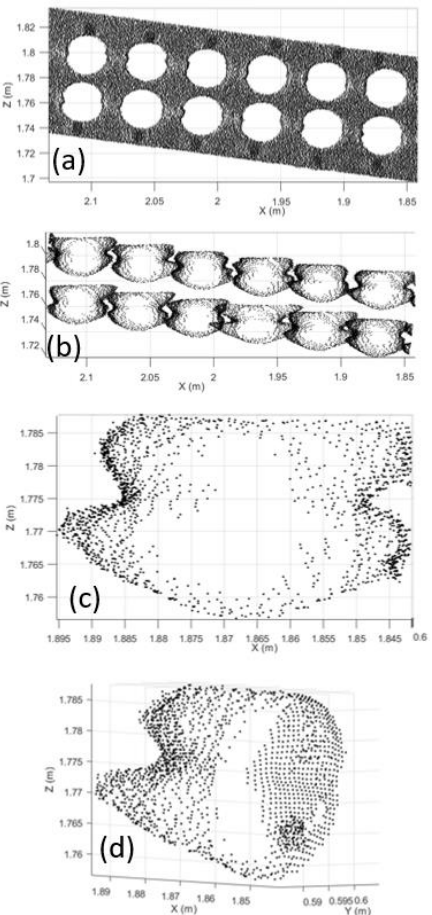
Figure 11: Biases shown in point cloud from two oblique angles; (a) planar surface of the drilling template, (b) returns from inside the drill holes with top surface removed, (c) and (d) plan and 3D view of the same singular drill